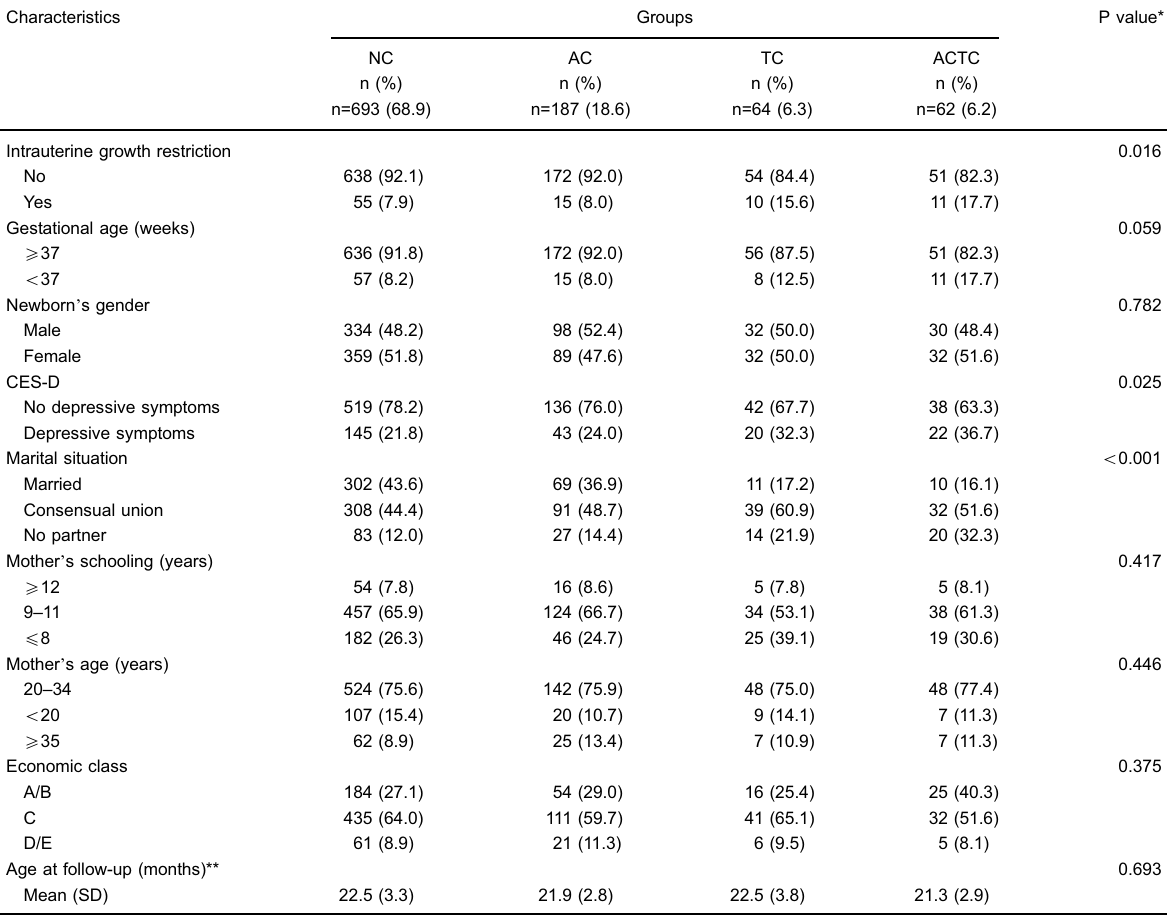
Table 2. Comparison of the characteristics of groups NC, AC, TC, and ACTC in Ribeirão Preto, SP, Brazil, 2010/13. Characteristics